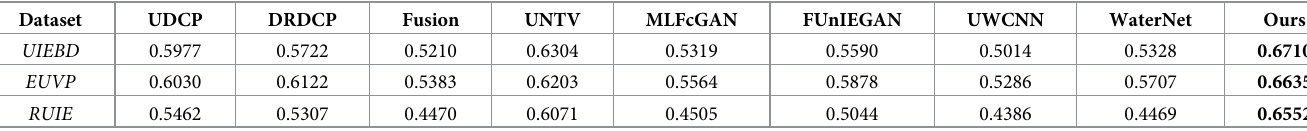
Table 3. UCIQE of evaluation results on test datasets.